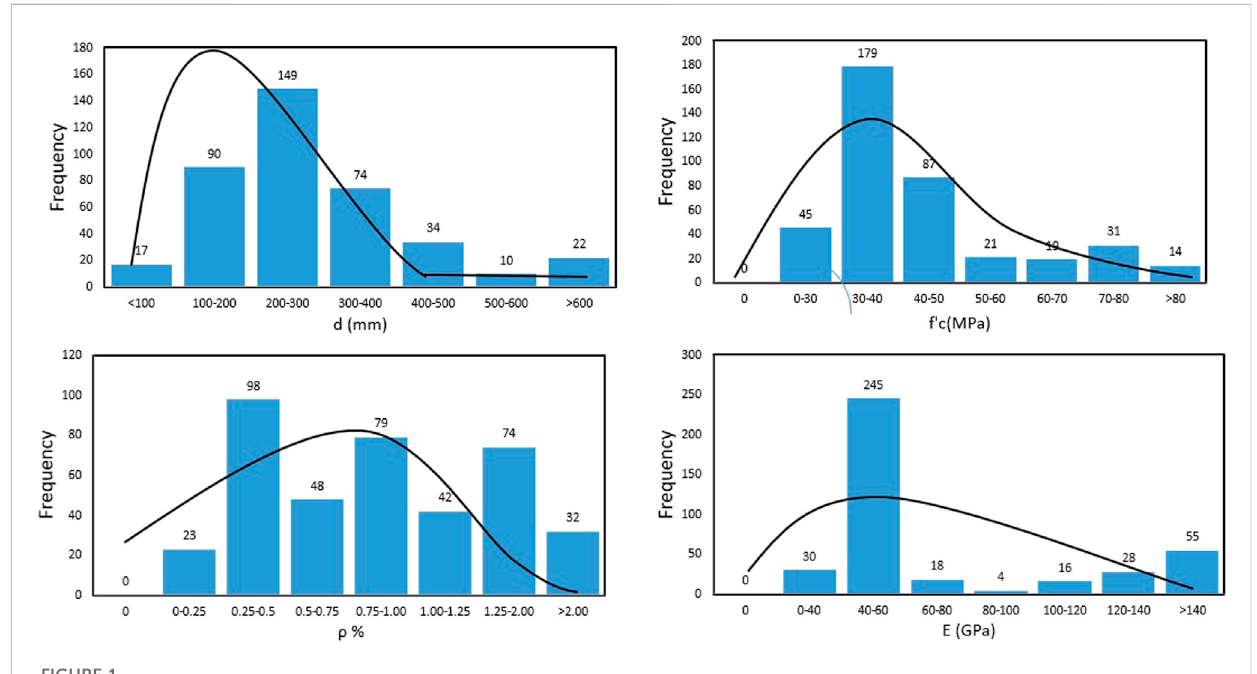
FIGURE 1 Database frequency